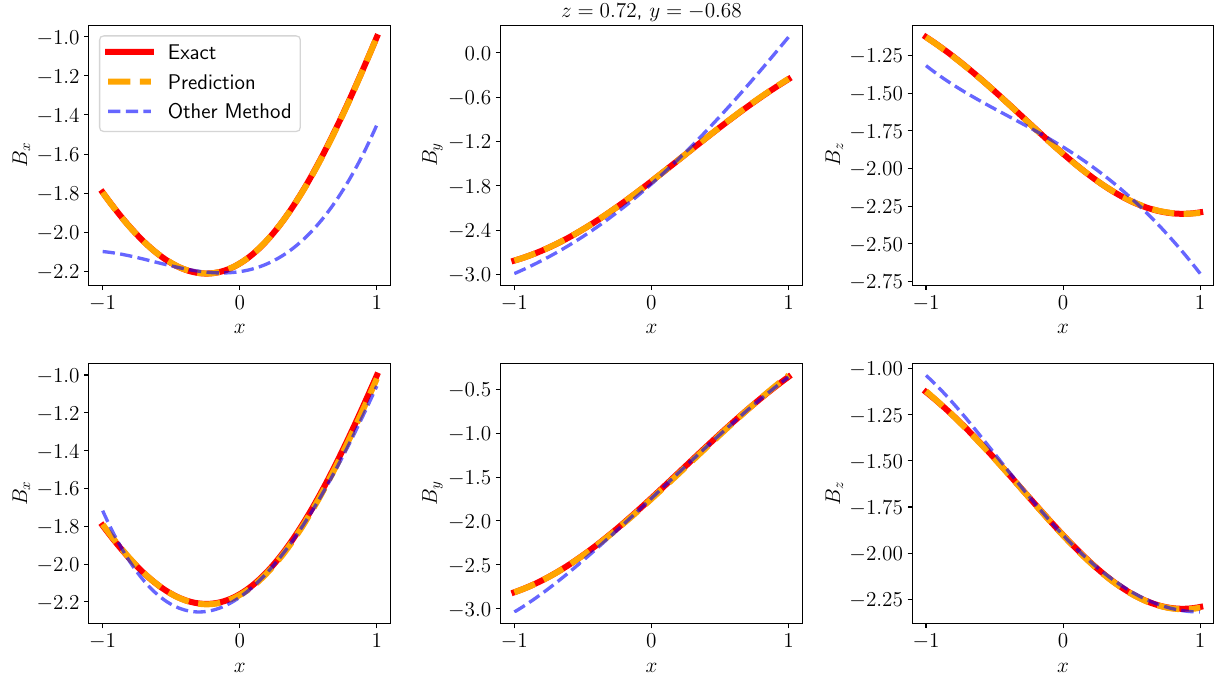
Figure 5. Top: Comparison of the predicted and the other method’s solutions’ x , y , z directions with 18 sensor data with Gaussian noise with σ = 1.0 × 10 − solutions’ x , y , z directions with 30 sensor data with Gaussian noise with σ = 1.0 × 10 −